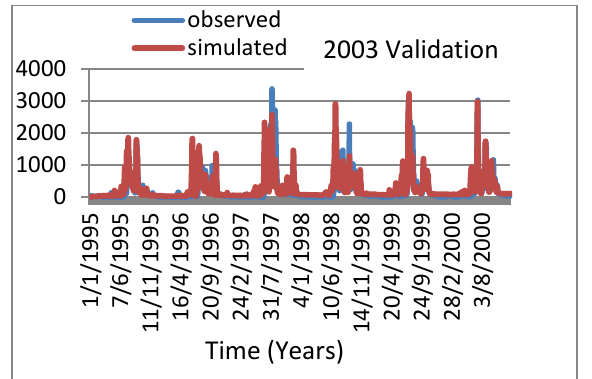
Figure 19 Line graph showing simulated and observed runoff vs time at daily time step for the year 2003 (Validation)